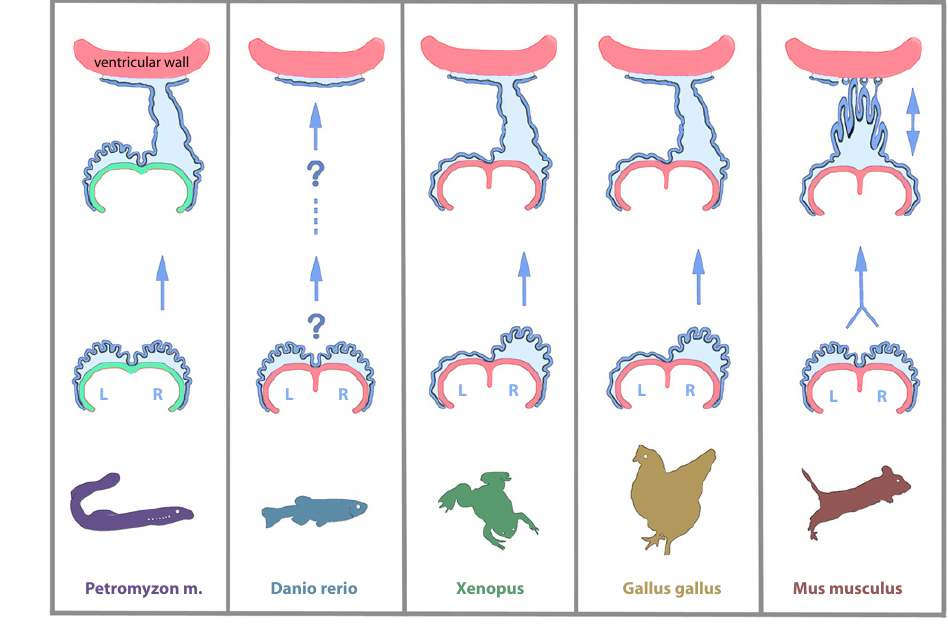
Figure. 2 Asymmetrical PE development and mechanisms of cell transfer. The PE is formed as an asymmetrical outgrowth of mesothelial cells (blue) on the bilateral sinus venosus (red) in different vertebrates like Xenopus and chick, which ultimately forms a tissue bridge to establish contact to the surface of the ventricular wall and to colonize the heart. This morphological feature remains unclear in the zebrafish whereas in the lamprey Petromyzon only the right of initially two bilateral PE anlagen forms a transient tissue bridge, which arises from the coelomic wall (green). PE development in the mouse appears to be symmetrical with two bilateral anlagen fusing on the midline. After massive outgrowth, the cells attach to the ventricle and are subsequently pulled off by the contracting heart. Thereby cell clusters attach to the myocardial surface and form islands of epicardium, which subsequently coalesce to establish a confluent epicardial